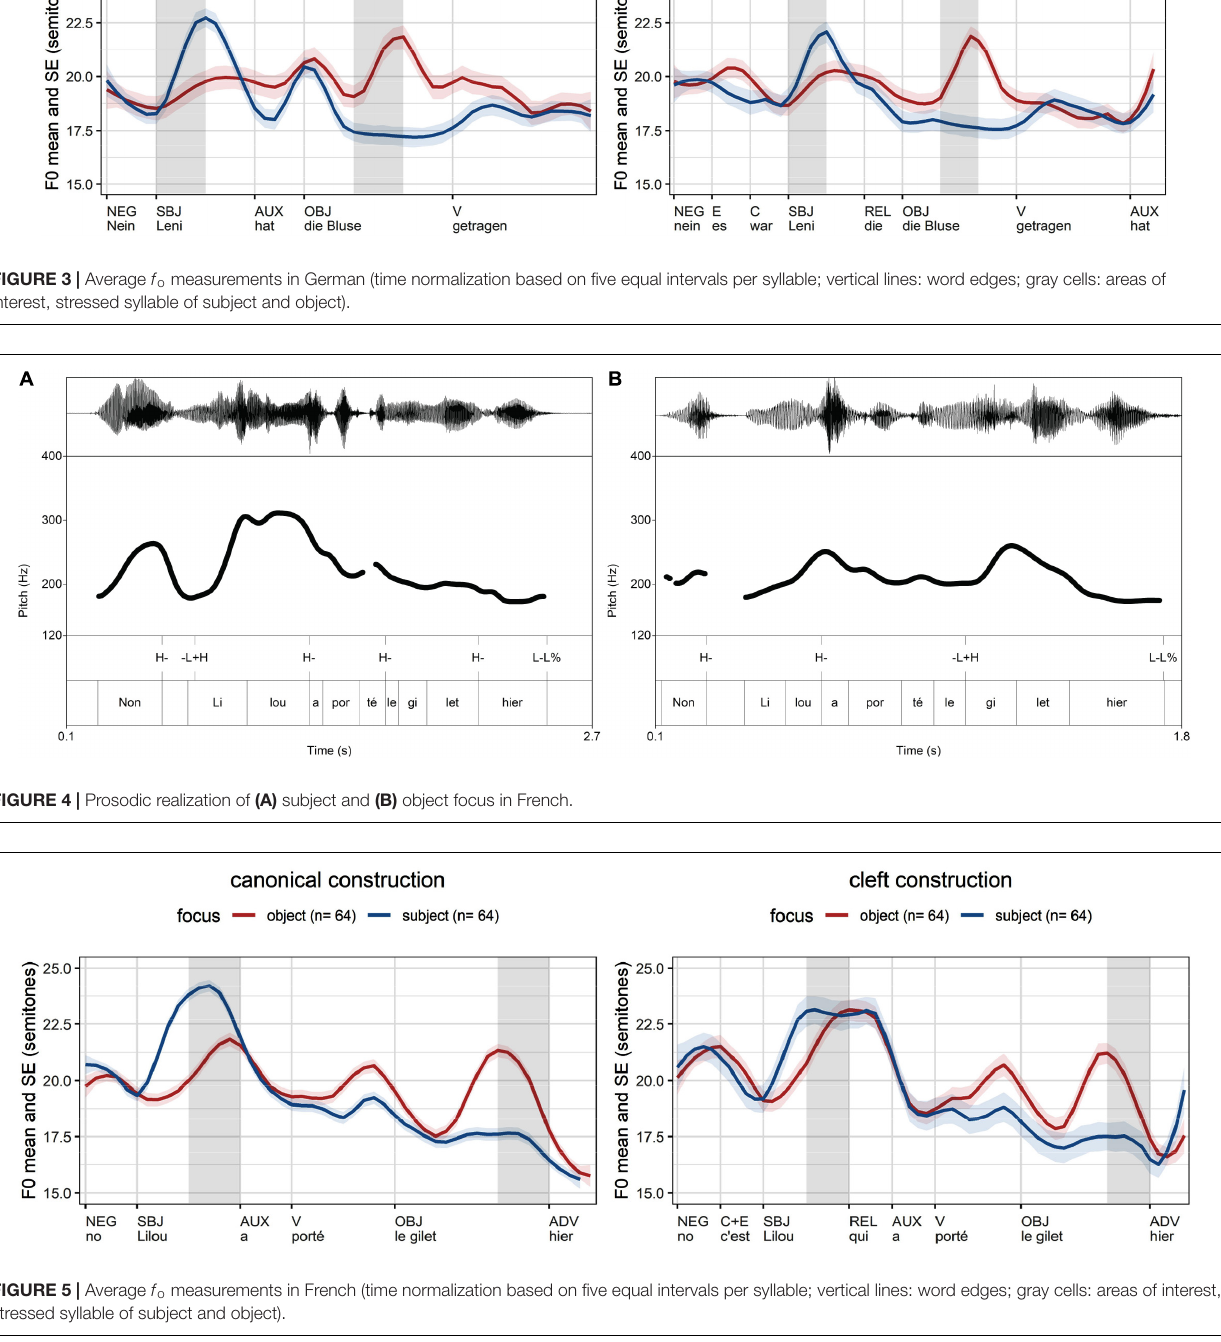
Mandarin Chinese displays a phonological contrast between four lexical tones (T1: high level; T2: rise; T3: fall-rise; T4: fall). The target words in our material contain the simple